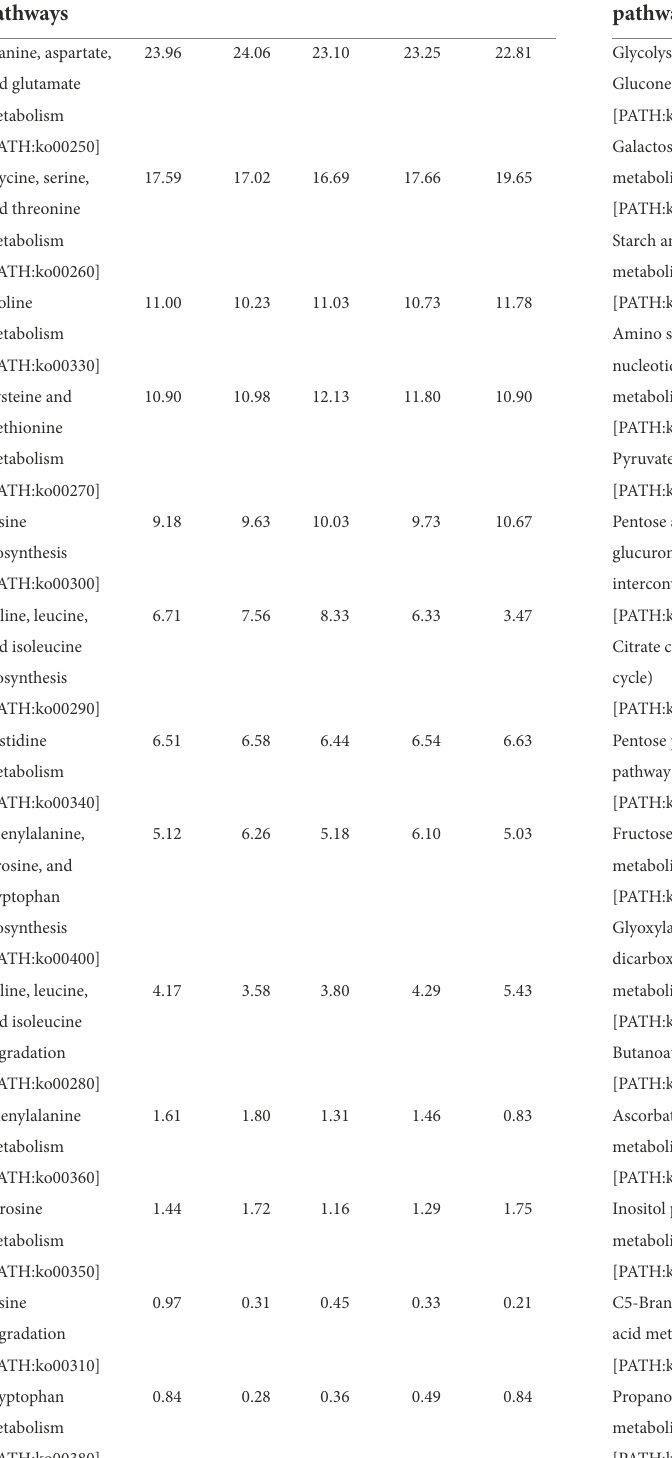
TABLE 6 Relative abundance (%) of sequences associated with carbohydrates metabolism pathways (KO level_3) in the caecum digesta samples from broiler chickens fed with diets containing different levels of marama bean